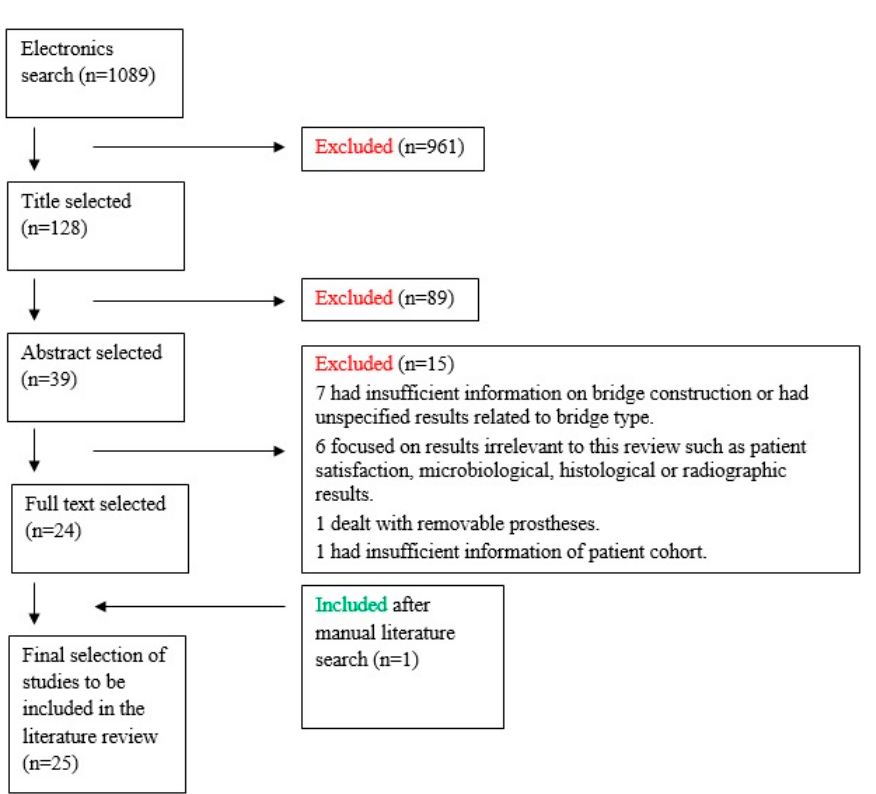
Figure 1. Flow chart of article selection.